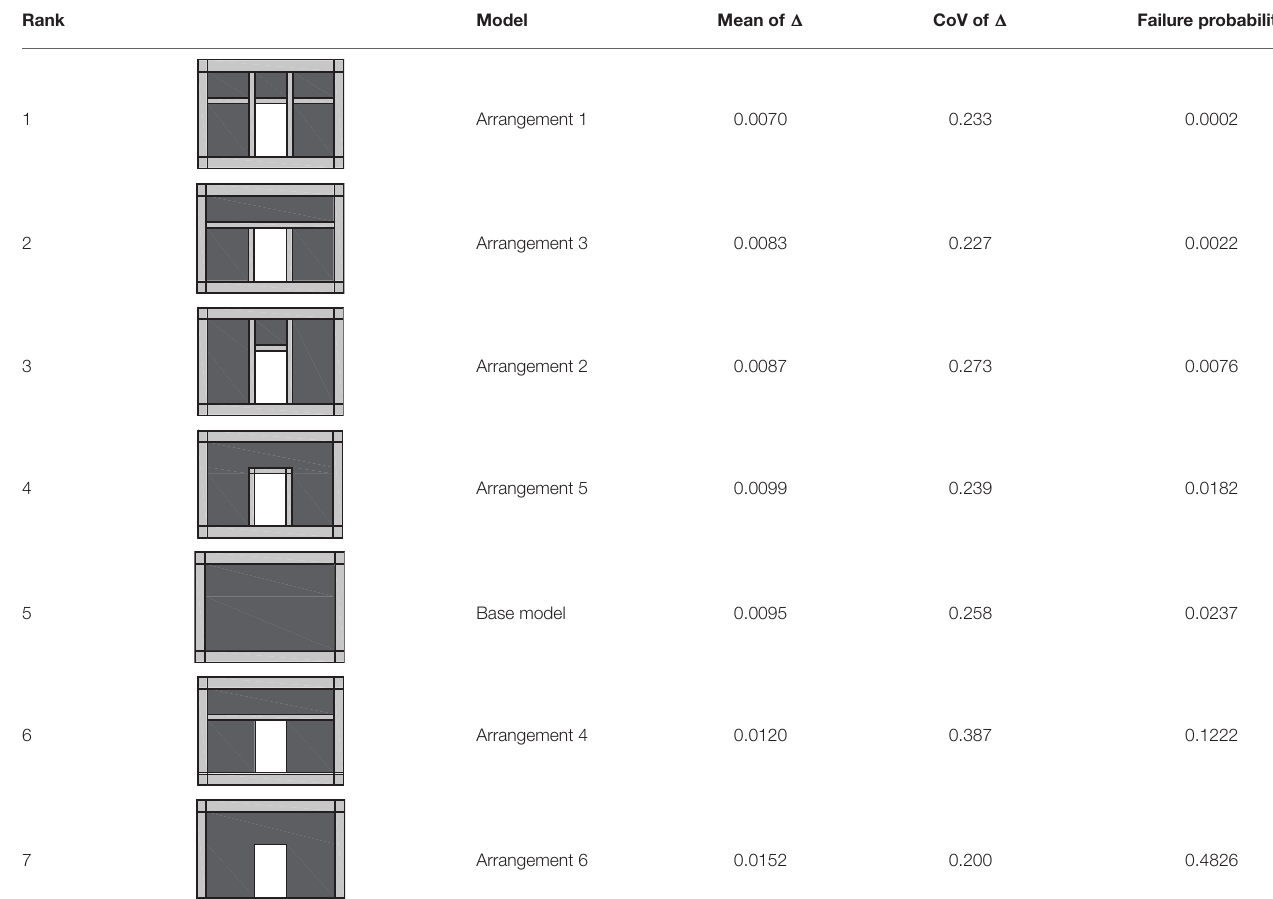
TABLE 3 | Ranking the models based on performance in descending